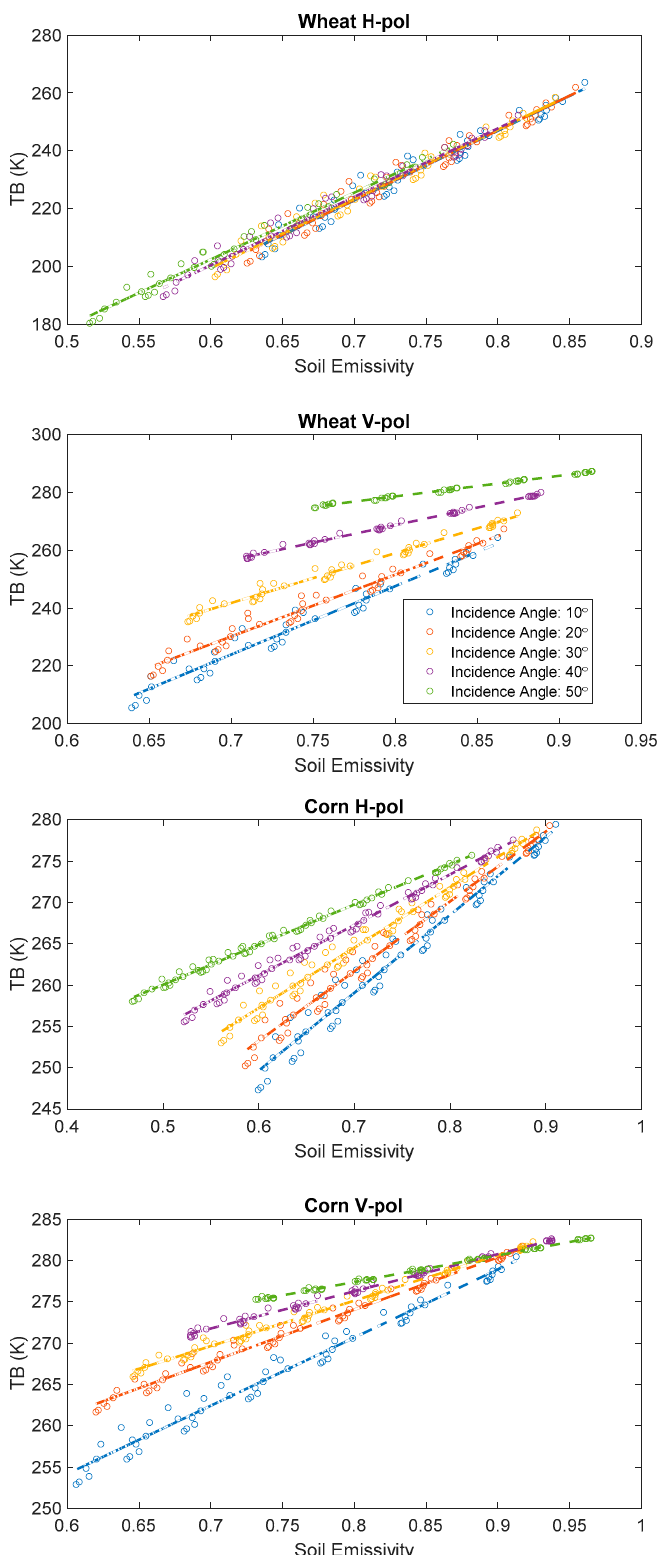
Figure 4. The linear relationship between Tor Vergata model brightness temperatures and bare soil emissivity in V and H pol. in different incident angles ( top : wheat, 70-cm canopy height; bottom : corn, 150-cm canopy height).